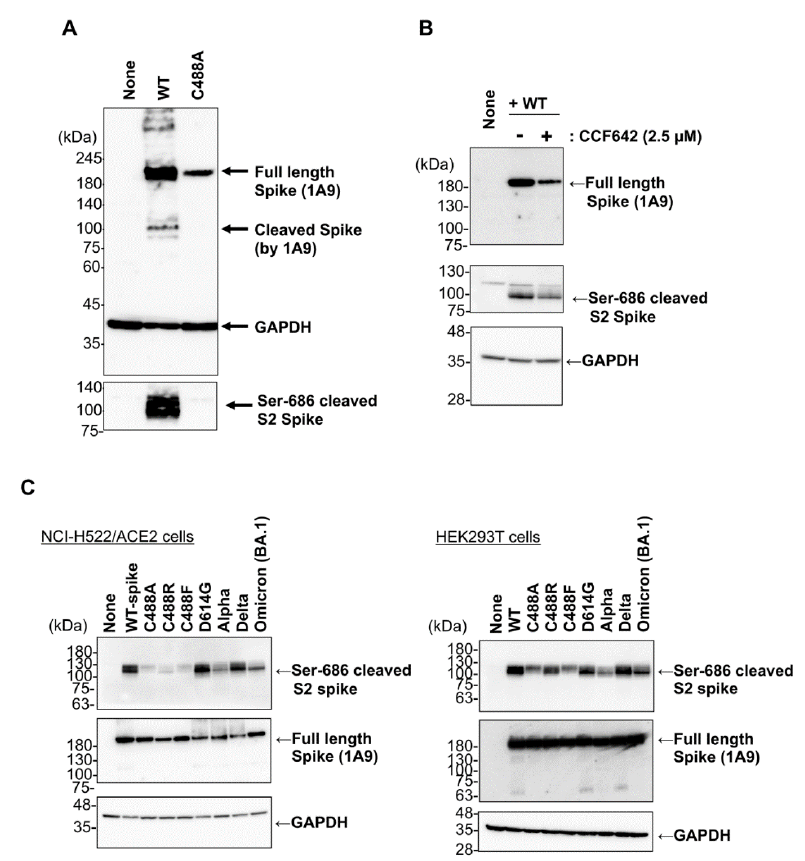
Figure 3. Defect of S1/S2 processing in C488 mutant spike proteins. ( A ) Spike-expressing plasmid was transfected into VeroE6/TMPRSS2 cells, and the cell lysate was prepared 20 h post-transfection. Full-length and Ser-686 cleaved spike proteins were probed with anti-spike (1A9) and cleaved SARS- CoV-2 spike (Ser686) antibodies, respectively. GAPDH is shown as a loading control. ( B ) Wild-type spike-expressing plasmid was transfected in HEK293 cells, which were treated with CCF642 for 13 h at 5 h post-transfection, followed by cell lysate preparation. Full-length and Ser-686 cleaved spike proteins were detected with anti-spike (1A9) and cleaved SARS-CoV-2 spike (Ser686) antibodies, respectively. ( C ) Each mutant spike-expressing plasmid was transfected in NCI-H522/hACE2 ( left panels ) and HEK293T ( right panels ) cells. After 20 h, cell lysates were prepared, and full-length and Ser-686 cleaved spike proteins were detected with anti-spike (1A9) and cleaved SARS-CoV-2 spike (Ser686) antibodies,